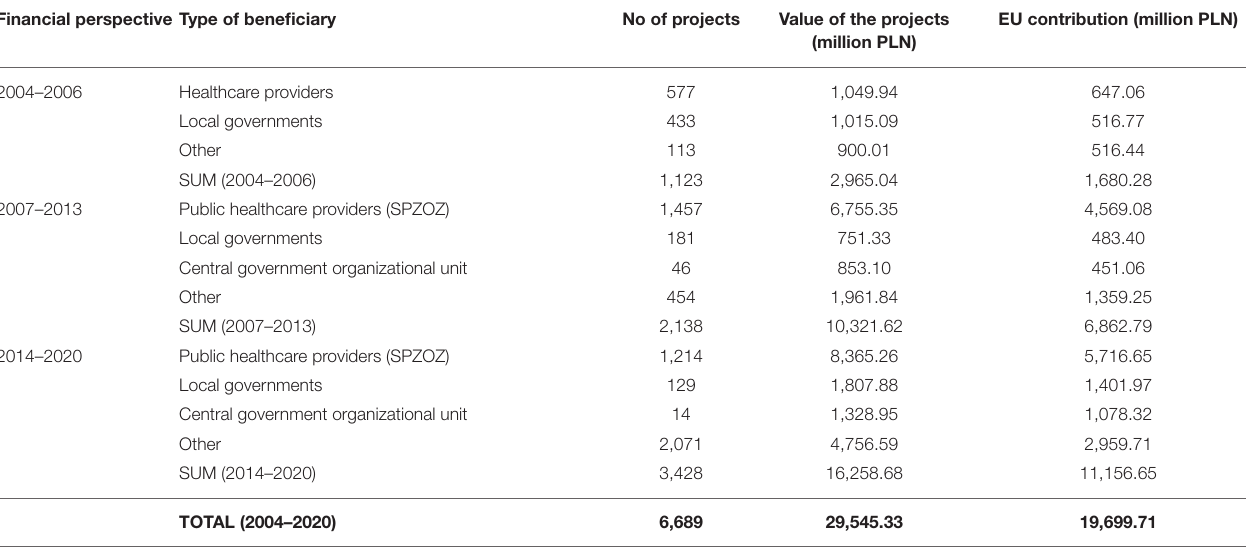
TABLE 2 | Infrastructure investments health related projects co-financed by the EU structural fund (ERDF) between 2004 and 2020, per financial perspective and type of beneficiary * . Financial perspective Type of